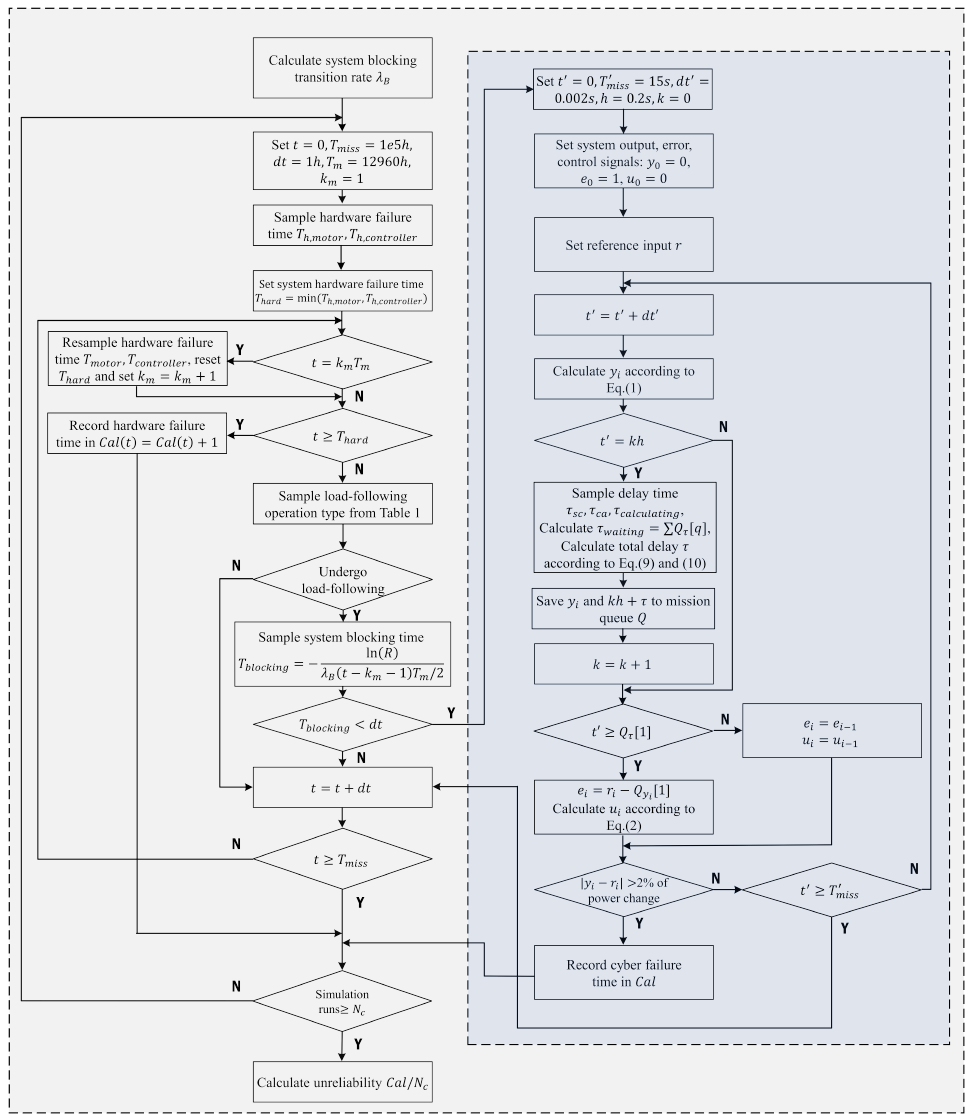
Figure 9. Flowchart of system unreliability calculation considering cyber aging and stochastic